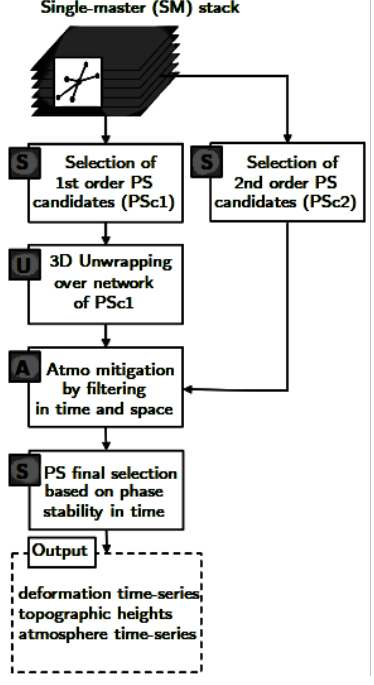
Figure 4. Generic flowchart of PSI processing. The steps are classified into Three basic InSAR processing blocks